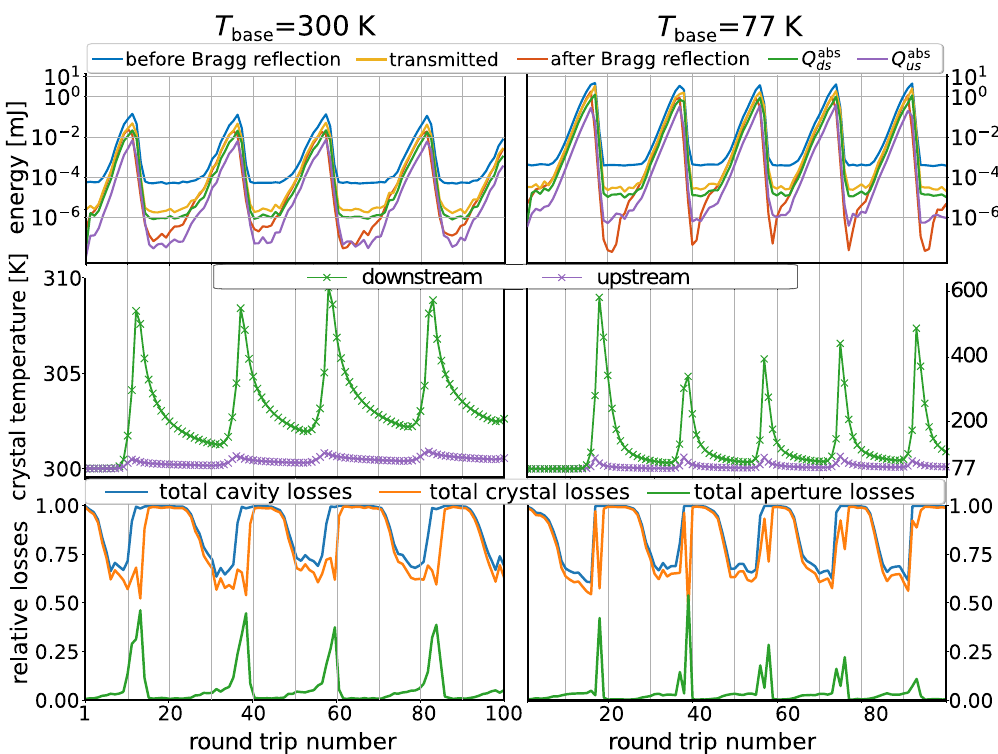
FIG. 6. Evolution of pulse energy (upper row) under influence of thermal load, the temperature of the crystal (middle row), and relative cavity losses L ¼ Δ Q=Q , where Q is similar to the blue line in the top row plot, with subsequent round trips. The crystal Und Und ¼ 300 K temperature is evaluated at the center of the incoming x-ray beam. The left column refers to a crystal base temperature of T base ¼ 77 K. The losses in the bottom row refer to the sum of all losses (room temperature) and the right column to the crystal cooled to T base in the cavity (blue line), the sum of absorption and transmission losses at both the crystals (orange line) and the cutoff losses introduced by the finite size of the KB mirrors (green line). For both temperatures, energy and temperature strongly correlate and show a highly unstable operation. Actually, the maxima in pulse energy and temperature are shifted by one round trip, as at the round trip, the pulse energy drops off, due to a missing overlap of spectral reflection and incident radiation (see Fig. 7), a higher fraction of incident radiation gets absorbed, leading to a very strong temperature rise. For the losses, one can see an anticorrelation between the aperture and crystal losses. As all the summed losses have to be ≤ 1 , a particularly strong rise in one of the loss channels causes a relatively smaller loss in the others. This does, however, not mean an actual drop of pulse energy loss in the total number. It is noteworthy that for the room temperature case, one can first see a strong rise in aperture losses, causing the break off of the CBXFEL seeding, and only afterward a rise in spectral losses. The latter is due to the loss of the seeding, causing a much higher fraction of transmission. For the cooled crystal case, on the other hand, the drop off is caused by a strong rise in spectral losses which is then followed by a rise in aperture losses at the next round